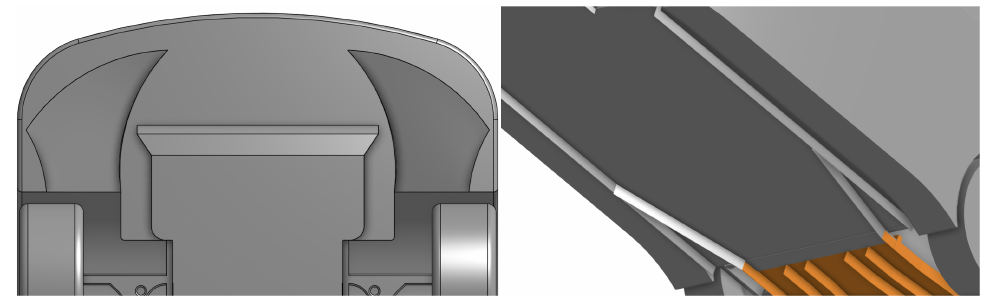
Figure 11. Bottom and inclined view of the front diffusers and diagonal sealing skirts,